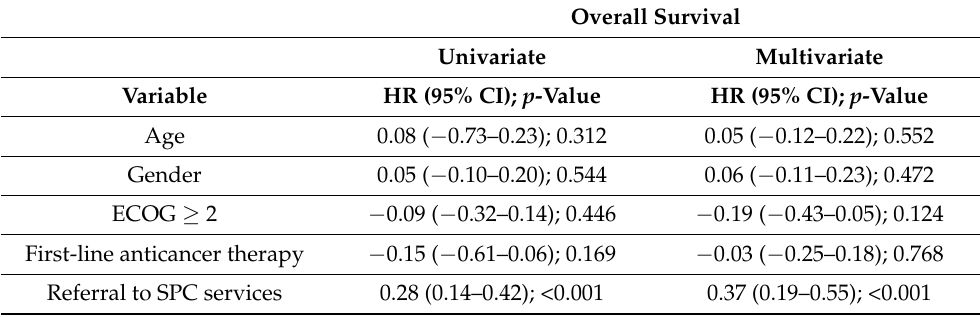
Table 3. Univariate and multivariate Cox